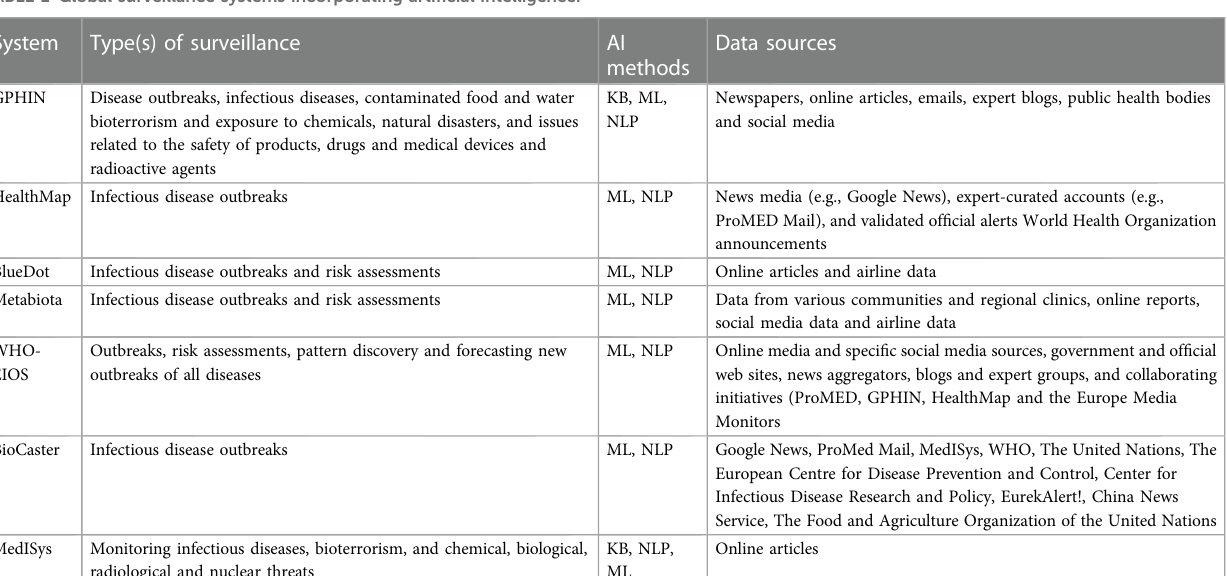
TABLE 1 Global surveillance systems incorporating arti fi cial